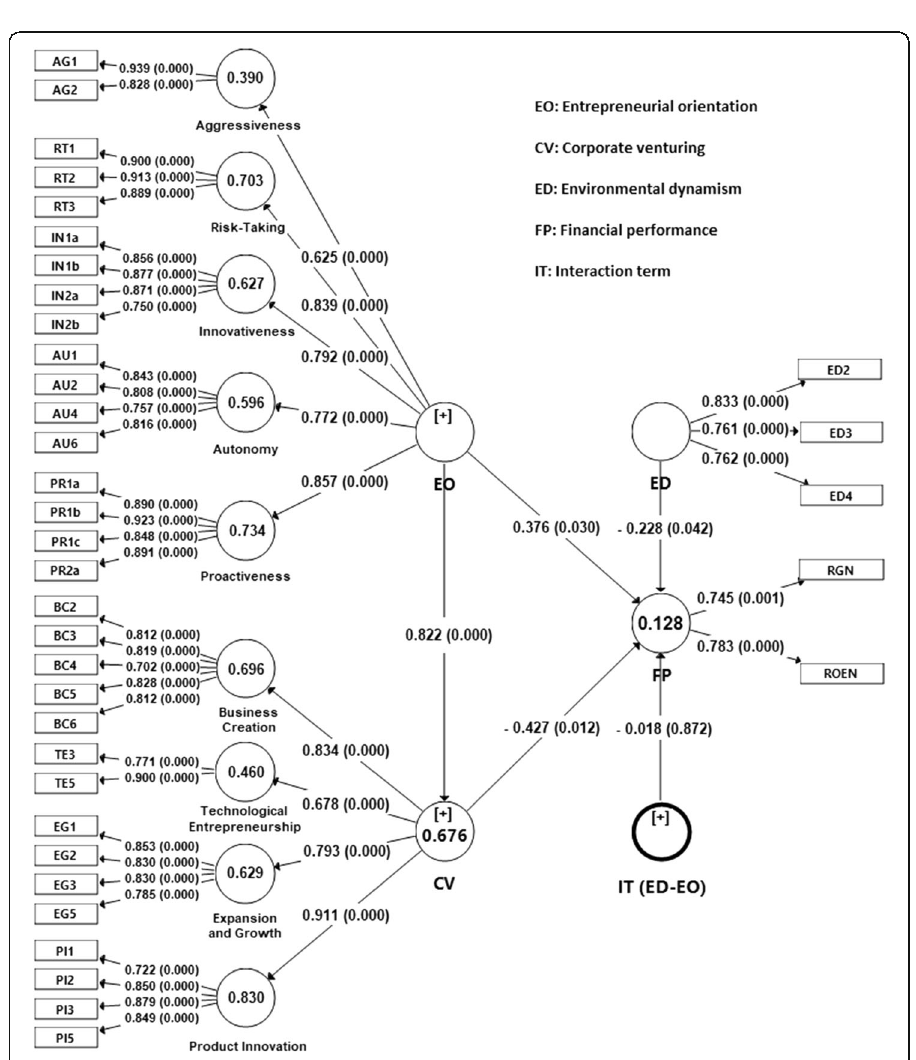
Fig. 2 Results of the SEM moderating effect of ED on EO and FP. Note . The names of the items correspond to the way they are labeled on their measurement